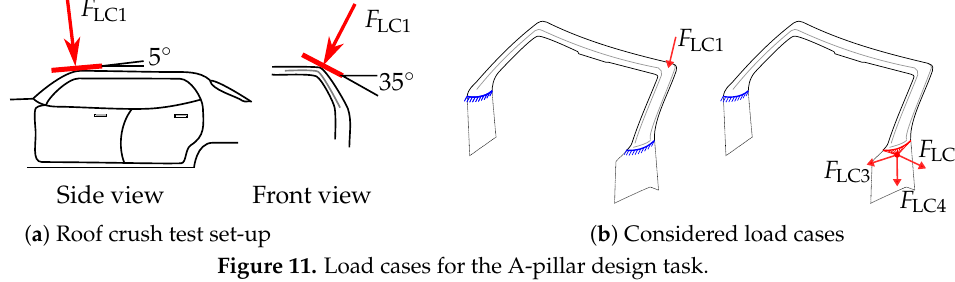
Figure 11. Load cases for the A-pillar design task.